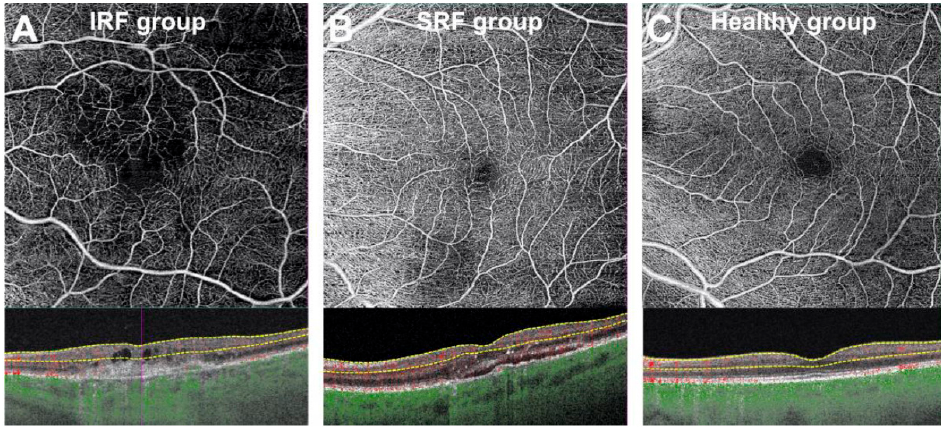
Figure 2. Optical coherence tomography angiography representative images of the superficial capillary plexus at T0 in eyes with intraretinal fluid ( A ) and subretinal fluid ( B ) compared to healthy subjects ( C ). In the DCP at T0, eyes from the IRF ± SRF group showed significantly lower MPD and MVD than the healthy eyes ( − 13.4 95%CI ( − 19.0, − 8.0), p < 0.001 and –5.6 95%CI ( − 8.3,